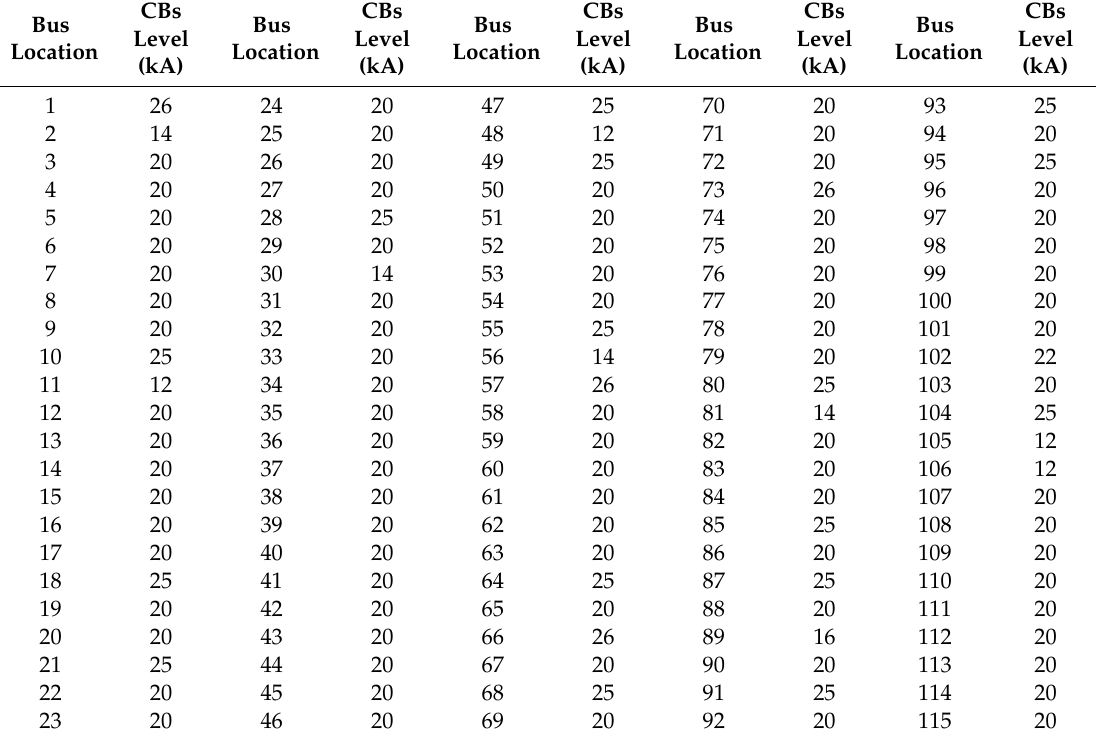
Table 3. CBs level of each bus in the BREC